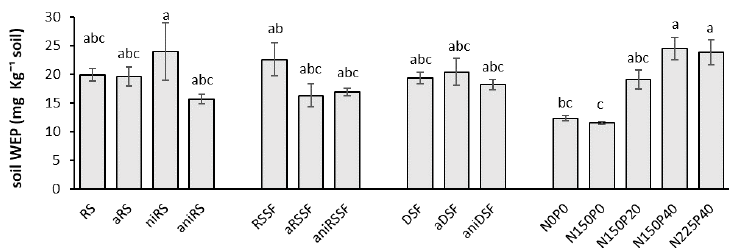
Figure 7. Postharvest WEP in soils applied with untreated and acidified slurries and reference mineral fertilizers 35 DAS as mean values of 4 replicates. RS: Raw slurry; RSSF: Raw slurry solid fraction; DSF: Digestate solid fraction; a: Acidified; ni: Nitrification inhibitor; ani: acid+ni; NxPy: mineral N and P reference fertilizer at x mg N and y mg P kg − 1 soil. Error bars represent standard error of the mean ( n = 4). Treatments with different letters (across all levels) are significantly different ( P < 0.05) according to the Tukey test.